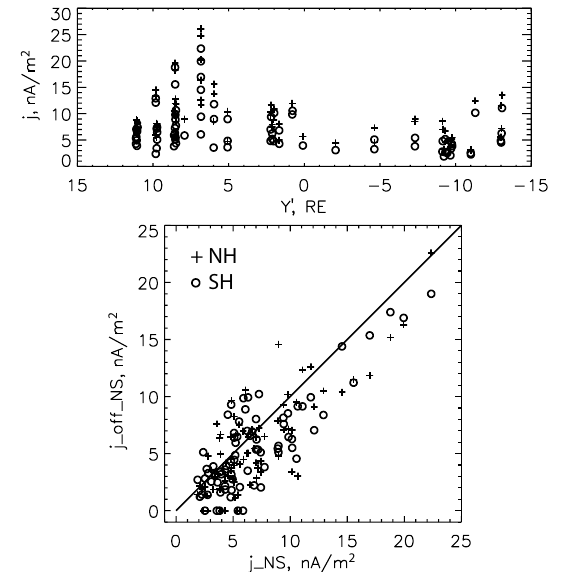
Fig. 12. Upper panel: Distributions of the maximum current density (crosses) and median current density in the NS (circles). Bottom panel: Distribution of median values of | j | in the NS and out of the